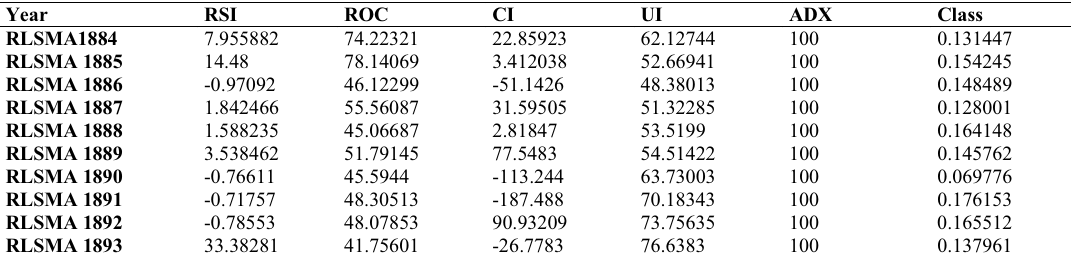
Table 3. Sample results after converting data with feature indicators (dataset3)